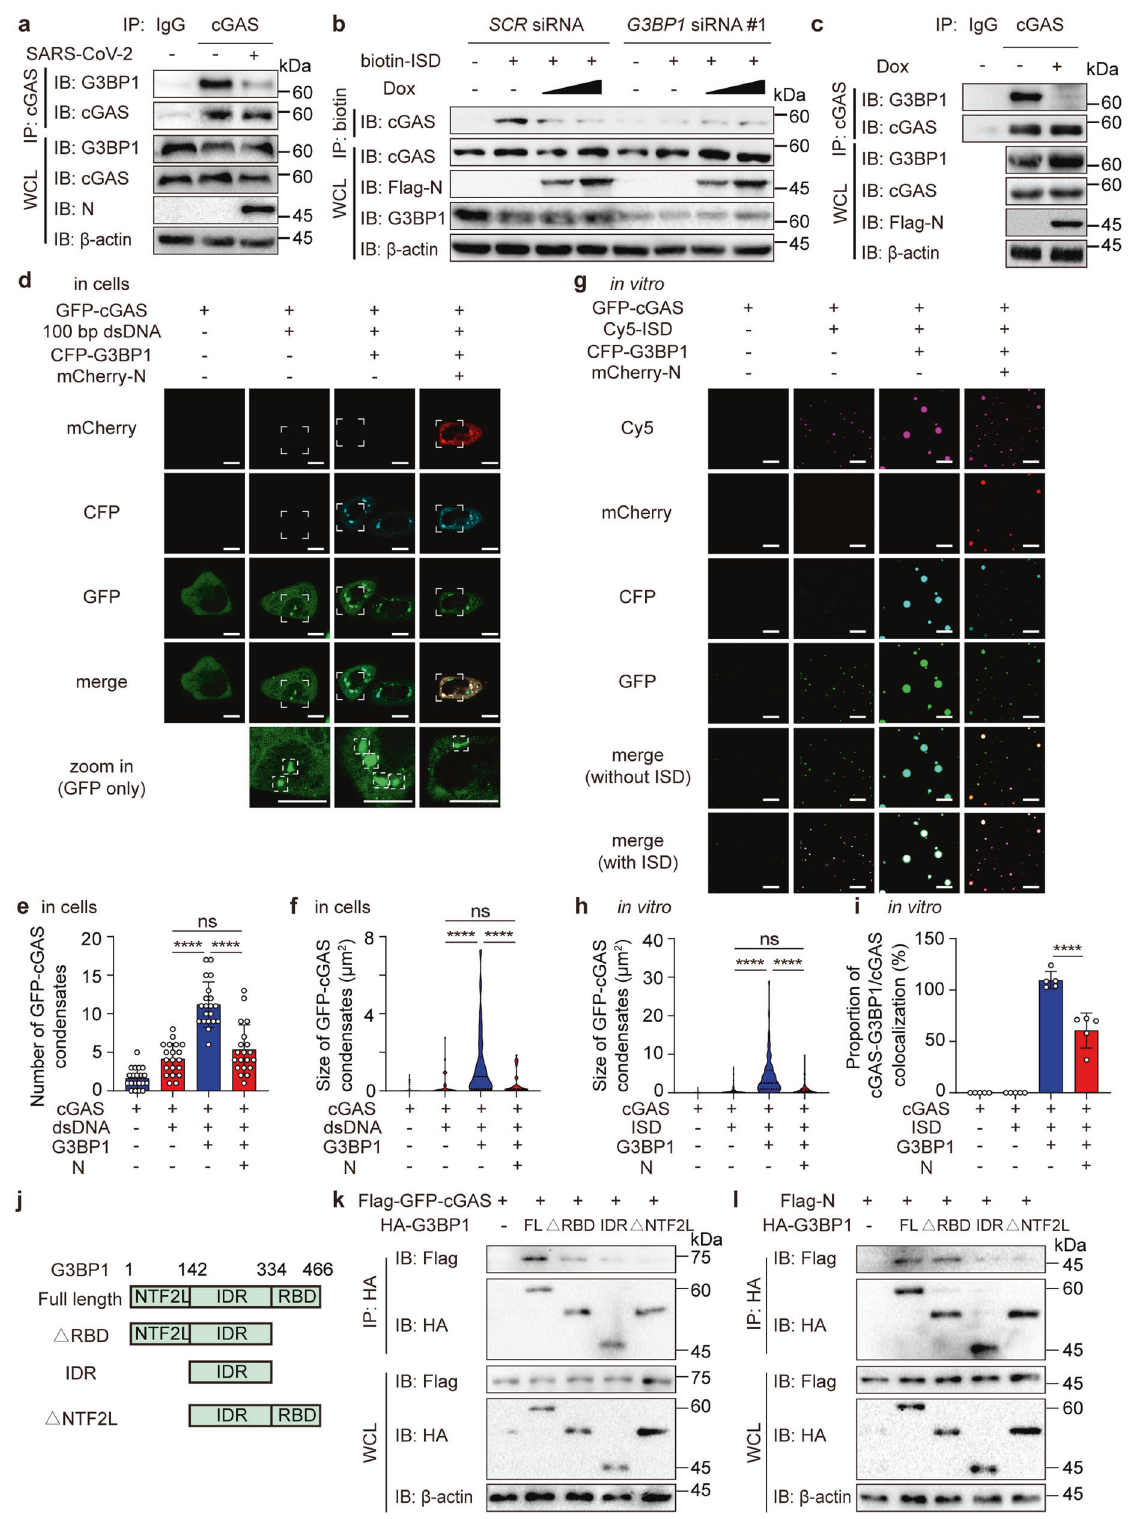
and △ SR mutant of N protein formed condensates with DNA stimulation (Supplementary Fig. 5b), while N protein △ CTD mutant only showed a dispersed pattern both in cells and in vitro compared with FL N protein and other N protein mutants (Fig. 5a and S5b). By fl uorescence recovery after photobleaching